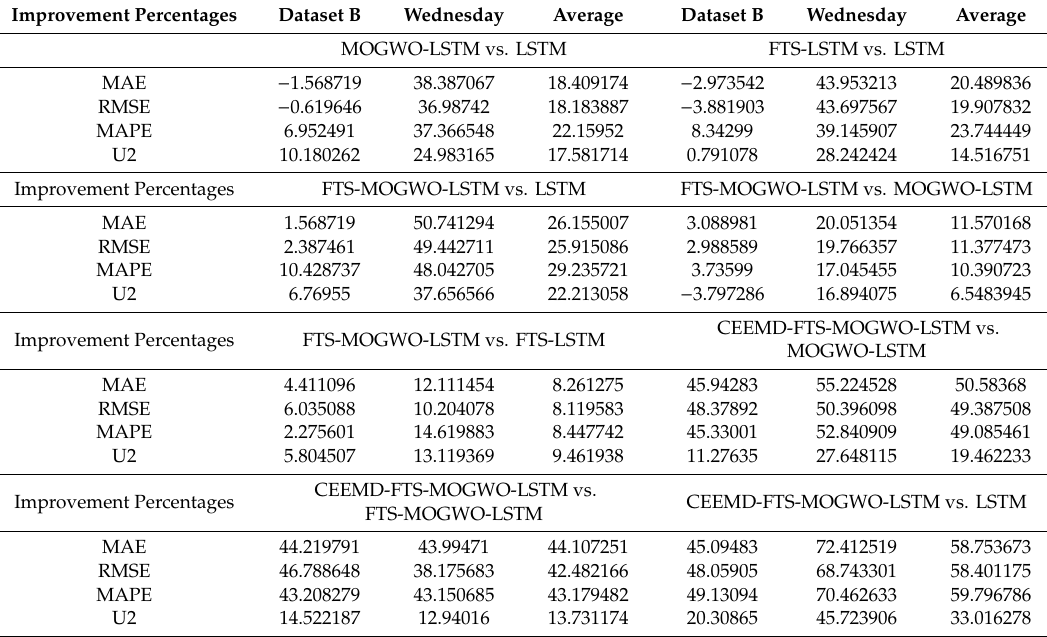
Table 12. Results for the discussion of improvement